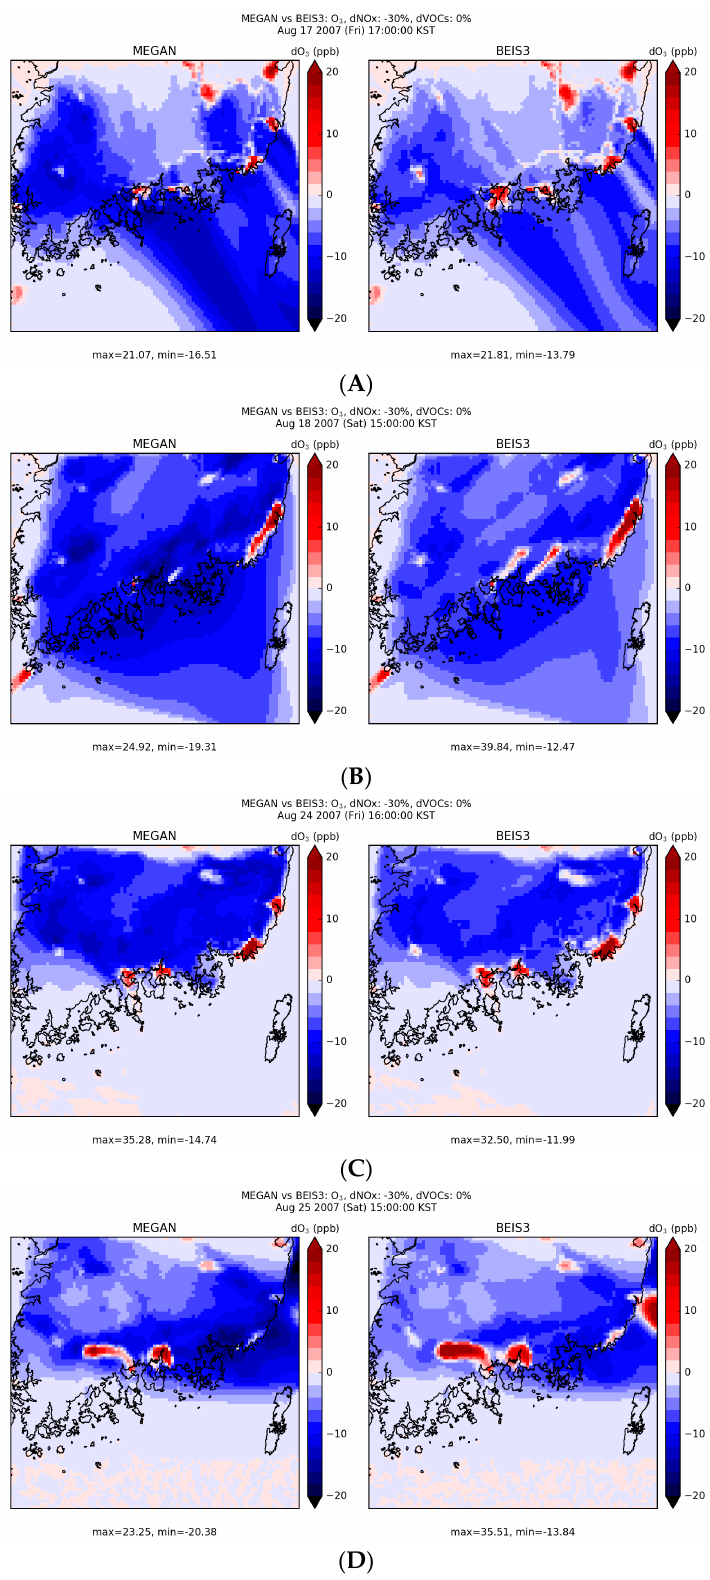
Figure 12. Ozone sensitivity to a 30% reduction in anthropogenic NO x with biogenic emissions estimated by MEGAN ( left ) and BEIS3 ( right ): ( A ) 5PM on 17 August; ( B ) 3 PM on 18 August; ( C ) 4 PM on 24 August; and ( D ) 3 PM on 25 August 2007.